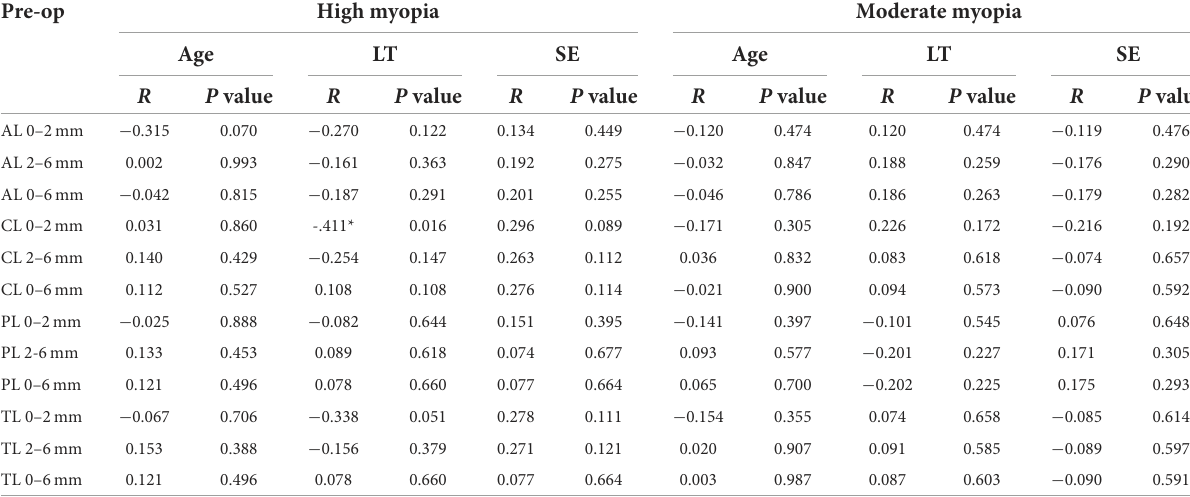
TABLE 4 Spearman correlation between corneal densitometry at last follow-up and preoperative parameters in high and moderate myopia group.